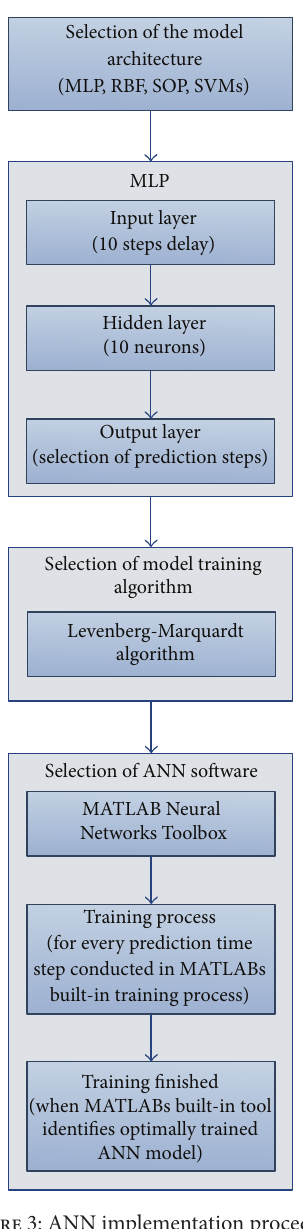
Figure 3: ANN implementation procedure.